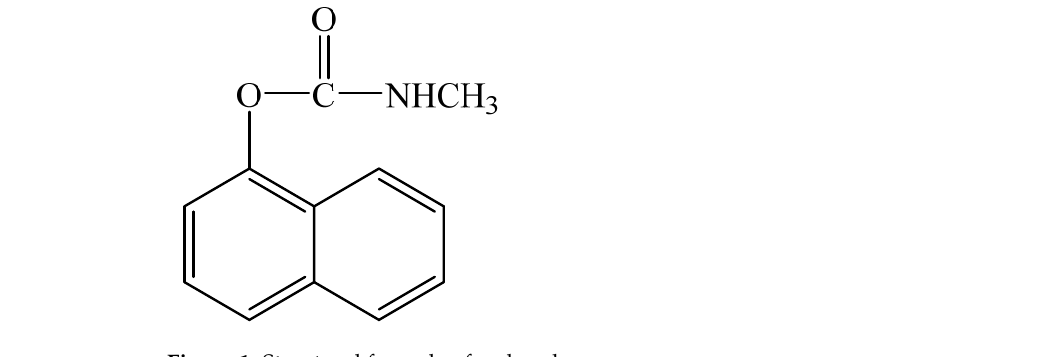
Figure 1. Structural formula of carbaryl.